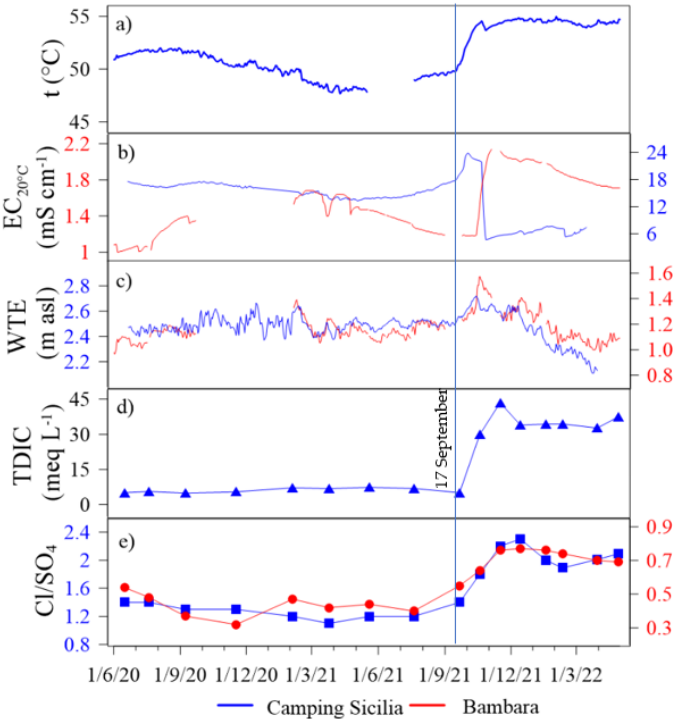
Figure 12. Time trends of some parameters measured in Camping Sicilia and Bambara well waters: ( a ) water temperature; ( b ) EC referred at 20 °C; ( c ) WTE); ( d ) TDIC; ( e ) Cl/SO 4 ratio.